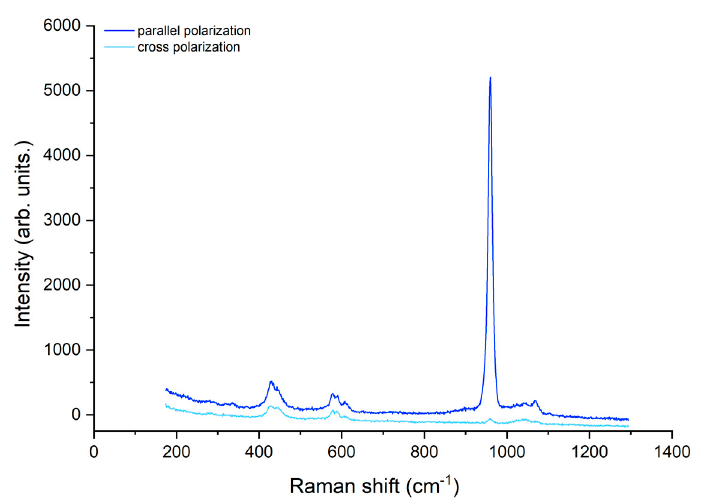
Figure 4. Spectra of a hypomineralized white opacity after treatment with GC Tooth Mousse.